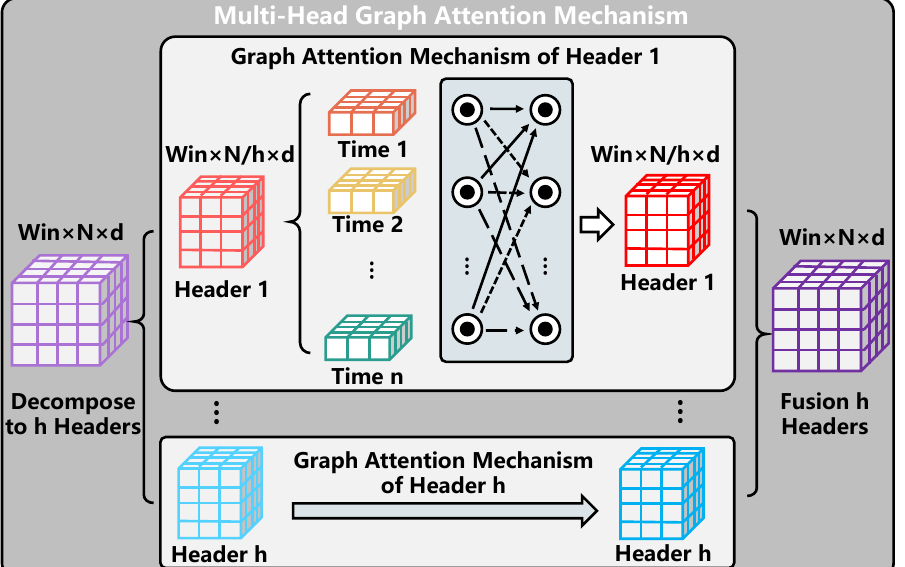
Figure 8. The calculation process of the high-dimensional